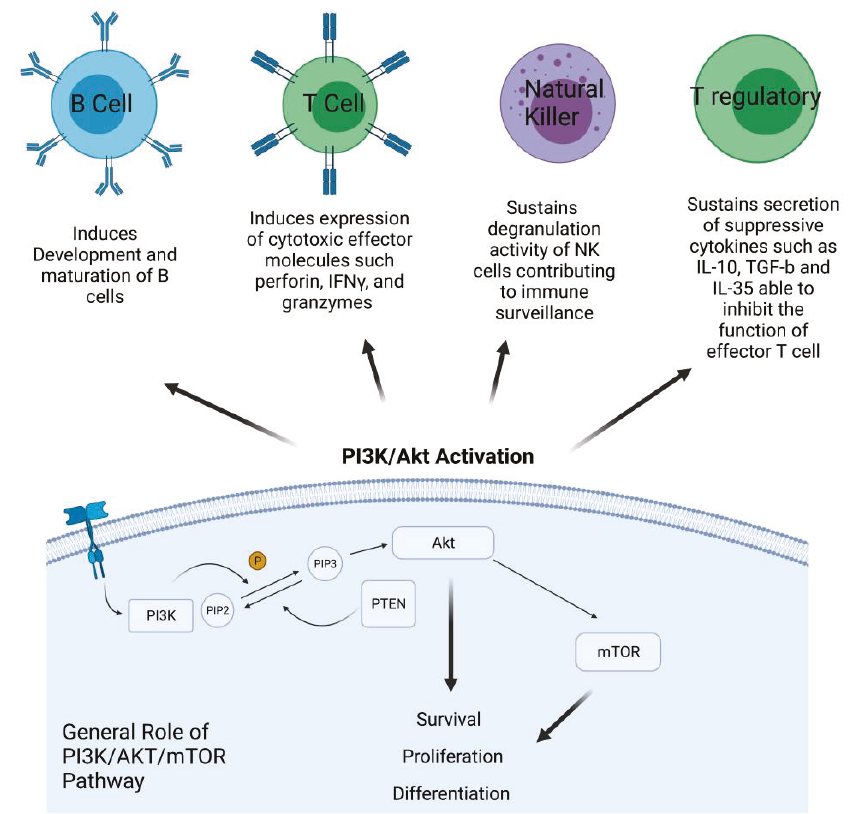
Figure 1. PI3K/Akt activation in cancer cells and its role in different kind of immune cells. PI3K is activated by growth factor receptors and, through the phosphorylation of PIP2 in PIP3, activates AKT that, in turn, activates mTOR. The effects of this activation involve survival, proliferation, and cell differentiation. Description of the effect of PI3K/Akt pathway activation in the main compartment of the immune system (Created with BioRender.com: agreement